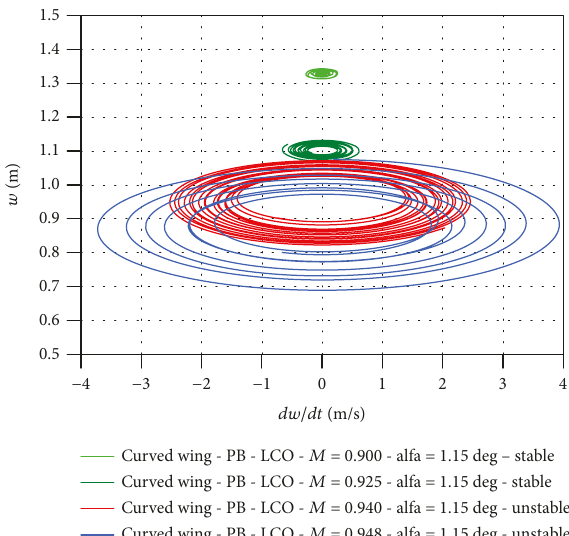
Figure 33: FSI analysis — estimation of fl uid power LCOs (Case 2) — density based.